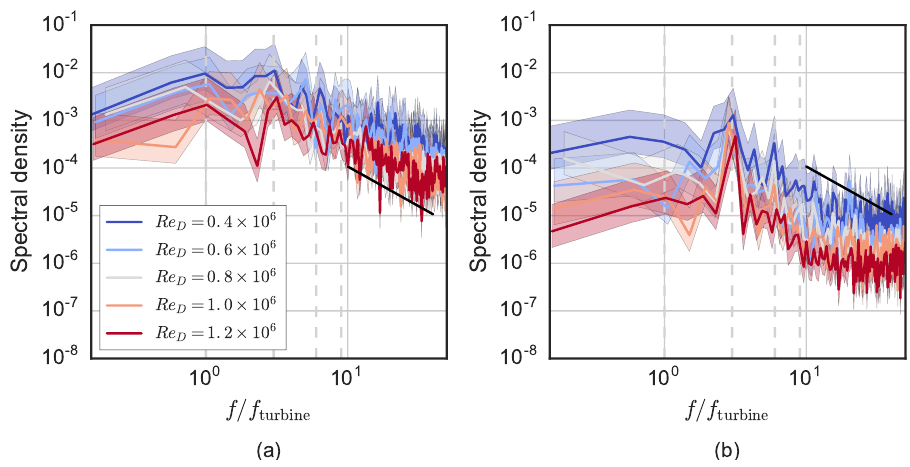
Figure 13. Cross-stream velocity (normalized by U ∞ ) spectra at z / H = 0.25, y / R = − 1.0 ( − 0.5 m in Figure 3) ( a ) and y / R = 1.5 ( + 0.75 m in Figure 3) ( b ). Dashed vertical lines indicate [ 1,3,6,9 ] times the turbine rotational frequency. Shaded regions indicate 95% confidence intervals assuming a χ 2